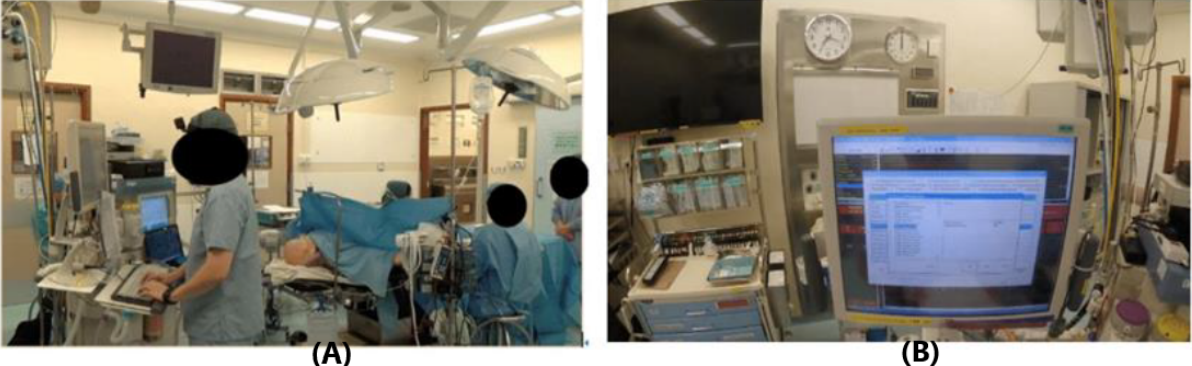
Figure 1. Video capture from the perspective of the operating room (A) and participant (B) while the participant was entering data into the anesthesia information management system during the simulation